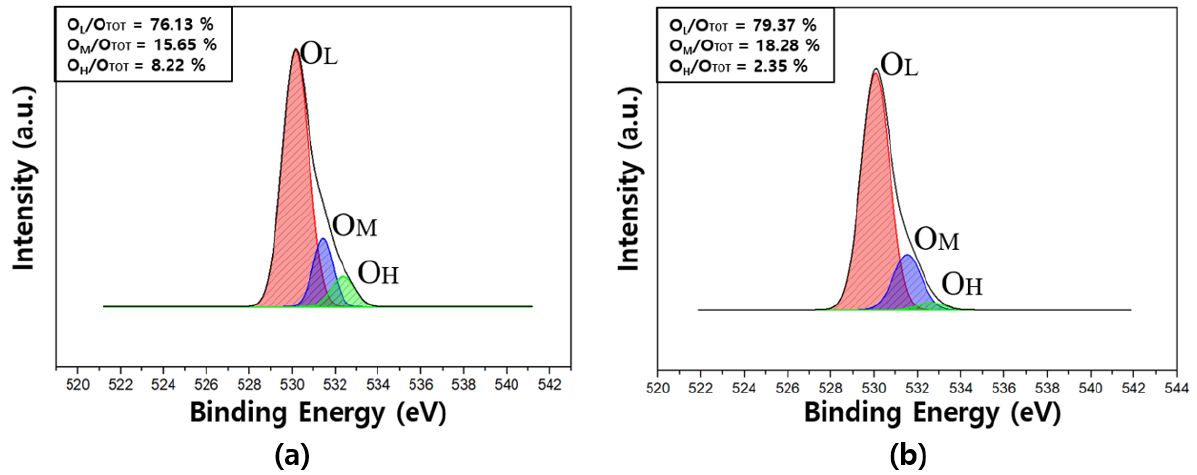
Figure 6. O 1s peak of XPS spectra of ( a ) con-ZTO DAL, and ( b ) self-ZTO DAL films. The O L /O TOT ratios of the con-ZTO and self-ZTO films were 76.13% and 79.37%, respectively. The O M /O TOT ratio of the con-ZTO film was 15.65%, and that of the self-ZTO film was 18.28%. Lastly, The O H /O TOT ratio of the con-ZTO film was 8.22%, and that of the self-ZTO film was 2.35%. The M–O bond serves the channel to move electrons in